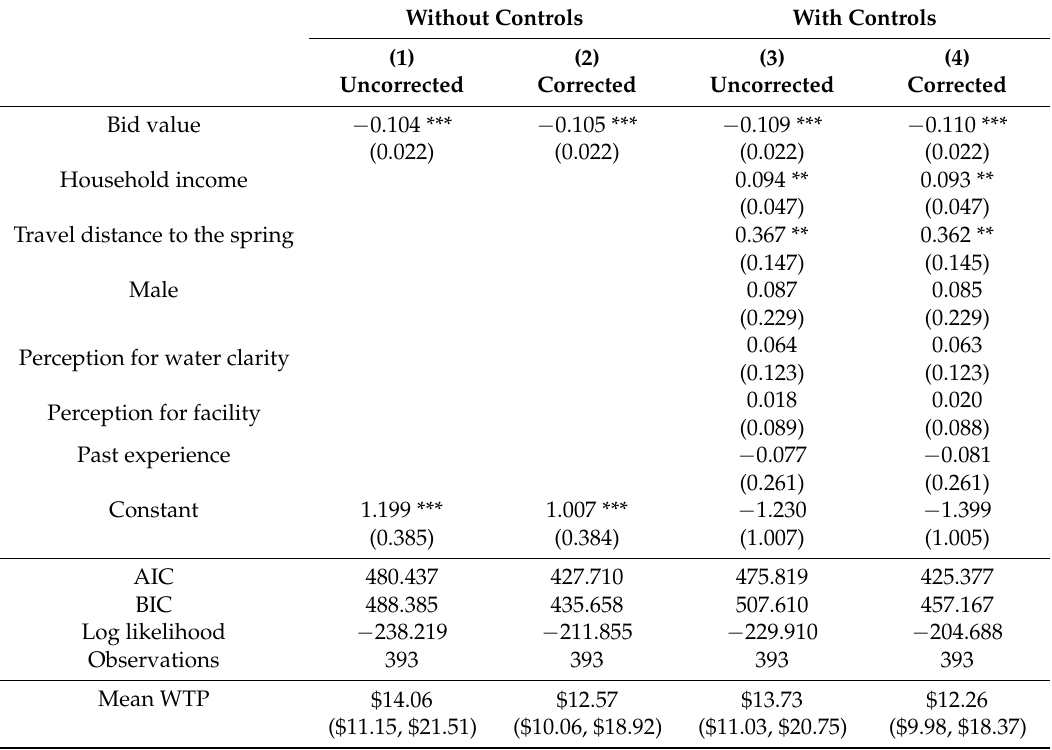
Table 6. Coefficient estimates of contingent valuation